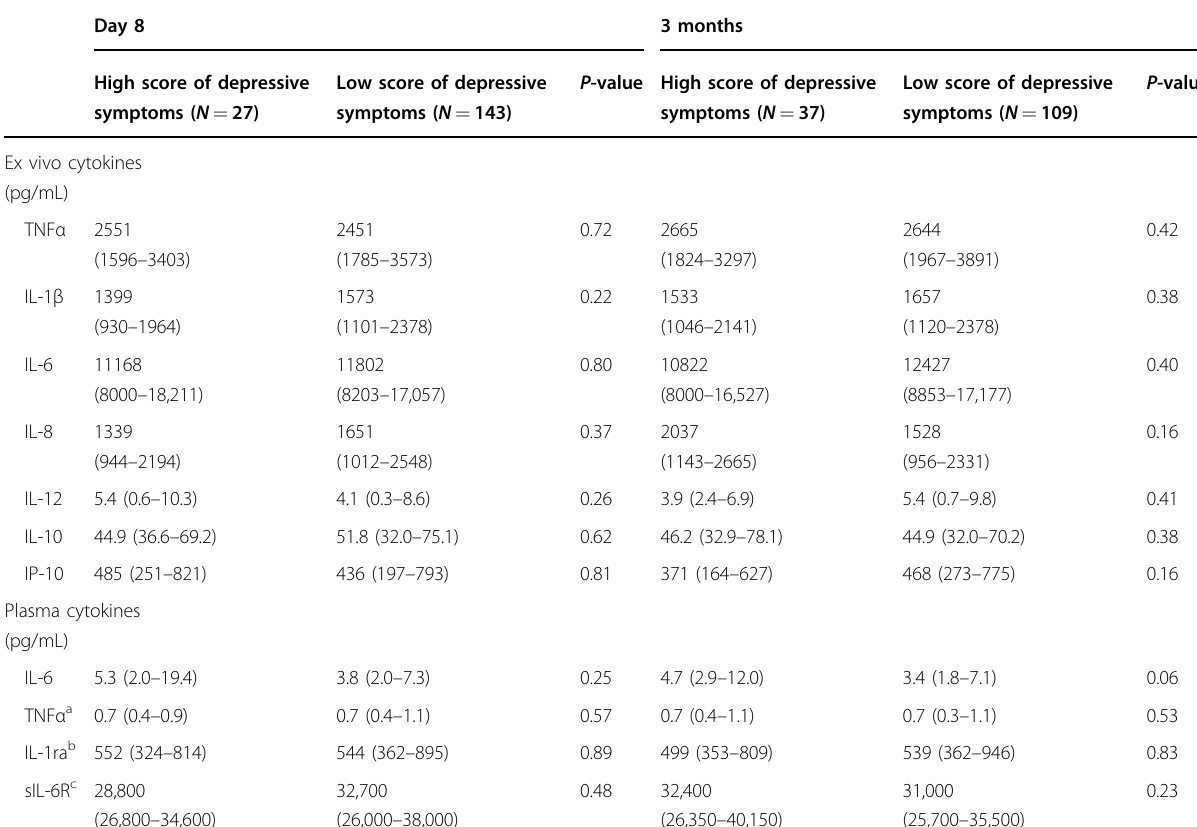
Table 3 Ex vivo synthesized and circulating cytokines in stroke